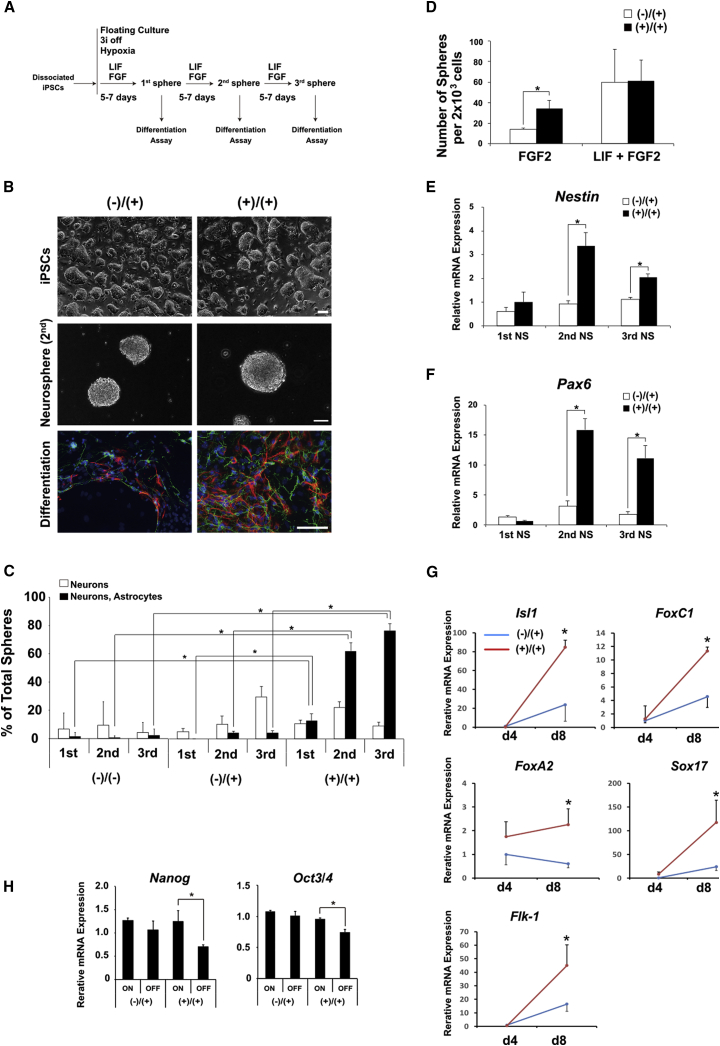
Differentiation Potentials of iPSCs Generated with or without the 3i Chemicals(A) Schematic representation of the strategy for differentiation of iPSCs to the neural lineage. iPSCs were dissociated and cultured using a suspension method to form neurospheres that were treated with LIF and basic FGF2. The resulting neurospheres were transferred onto a poly-L-ornithine/fibronectin-coated chambered slide glass to differentiate into neurons and astrocytes.(B) Representative images of (−)/(+) and (+)/(+) iPSCs, iPSC-derived neurospheres, and immunocytochemical stains of neural cell marker proteins in the differentiated neuronal and glial cells derived from neurospheres are shown. Scale bars, 100 μm.(C) Differentiation efficiency of the first, second, and third neurospheres derived from (−)/(−), (−)/(+), and (+)/(+) iPSCs. The frequency of colonies consisting of neurons (βΙΙΙ-tubulin) and/or astrocytes (GFAP) was evaluated by immunocytochemistry and is presented as the percentage of positive colonies (n = 3; ∗p < 0.05).(D) Second neurospheres derived from (−)/(+) or (+)/(+) iPSCs were dissociated (to a final cell density of 10 cells/μL) and grown to form neurospheres in the presence of LIF + FGF2 or FGF2 alone. The number of subcloned spheres per 2 × 103 cells is shown (n = 3; ∗p < 0.05).(E and F) mRNA expression of markers for neural progenitors, Nestin (E) and Pax6 (F) in the first, second, and third neurospheres was analyzed by qRT-PCR. The data are presented as the expression relative to that in (−)/(+) iPSCs (n = 3; ∗p < 0.05).(G) Gene expression of early mesodermal (Isl1 and FoxC1) and endodermal (Sox17, FoxA2, and Flk-1) markers in EBs derived from (−)/(+) and (+)/(+) iPSCs was analyzed by qRT-PCR. The data are presented as the expression relative to that in (−)/(+) iPSC-derived EBs on day 4 (n = 5; ∗p < 0.05).(H) Relative mRNA expression of pluripotency markers (Nanog and Oct3/4) in (−)/(+) and (+)/(+) iPSCs before or after withdrawal of 3i chemicals. The averages and SD of three different clones of (−)/(+) or (+)/(+) iPSC clones are represented (n = 3, ∗p < 0.05). Error bars represent mean ± SEM from three or five independent experiments (n = 3 or 5).